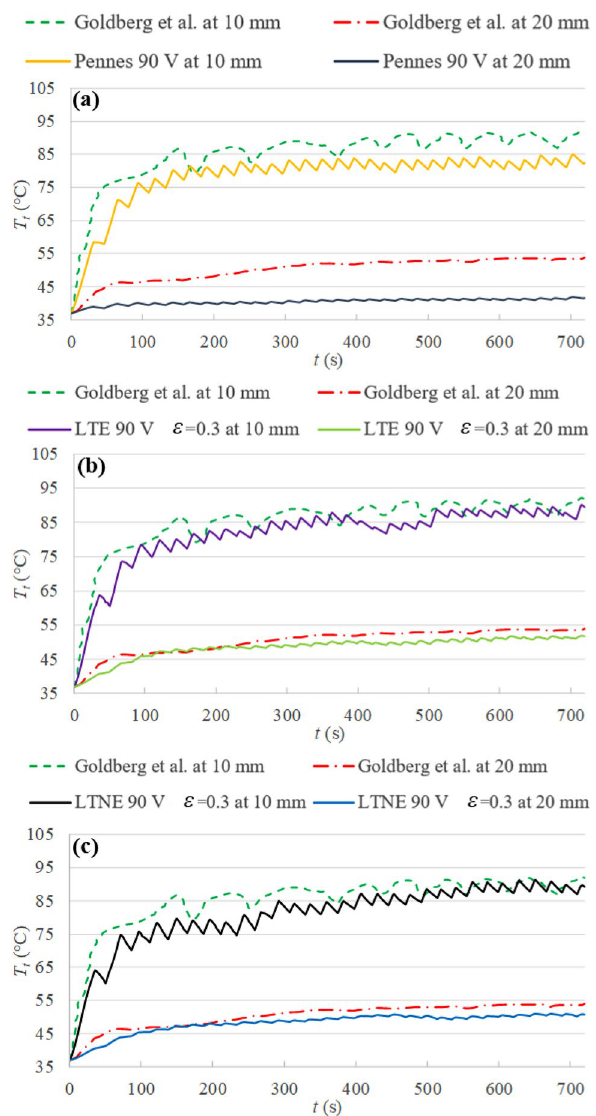
Figure 5. Temperature profiles for ( a ) Pennes’ equation, ( b ) LTE equation with ɛ = 0.3, (c ) LTNE equations with ɛ = 0.3, and in vivo experimental results obtained by Goldberg et al. 23